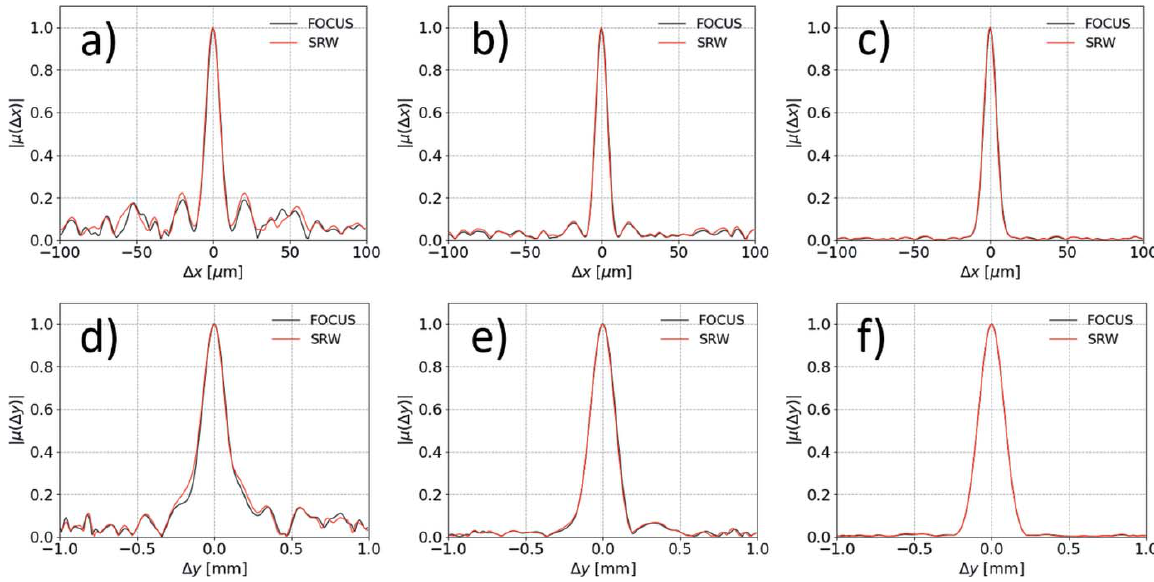
Figure 2 Direct comparison between FOCUS and SRW simulations for the horizontal ( a , b , c ) and vertical ( d , e , f ) profiles of the SDC of a typical third-generation undulator source. Results with N e = 10 3 ( a , d ), N e = 10 4 ( b , e ) and N e = 10 5 ( c , f ) are shown.